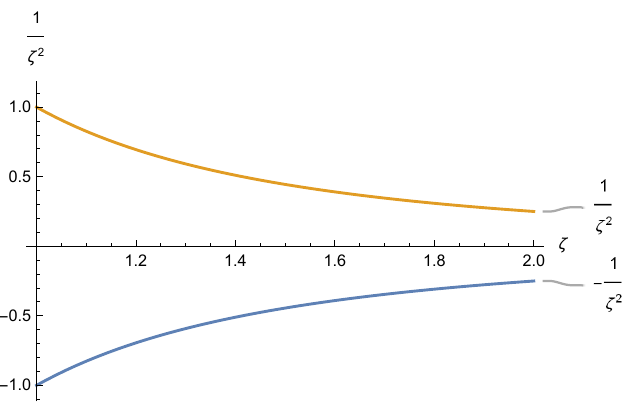
Figure 2. The plot of the function ˘ Υ = [ ˘ Υ , ˘ Υ ]